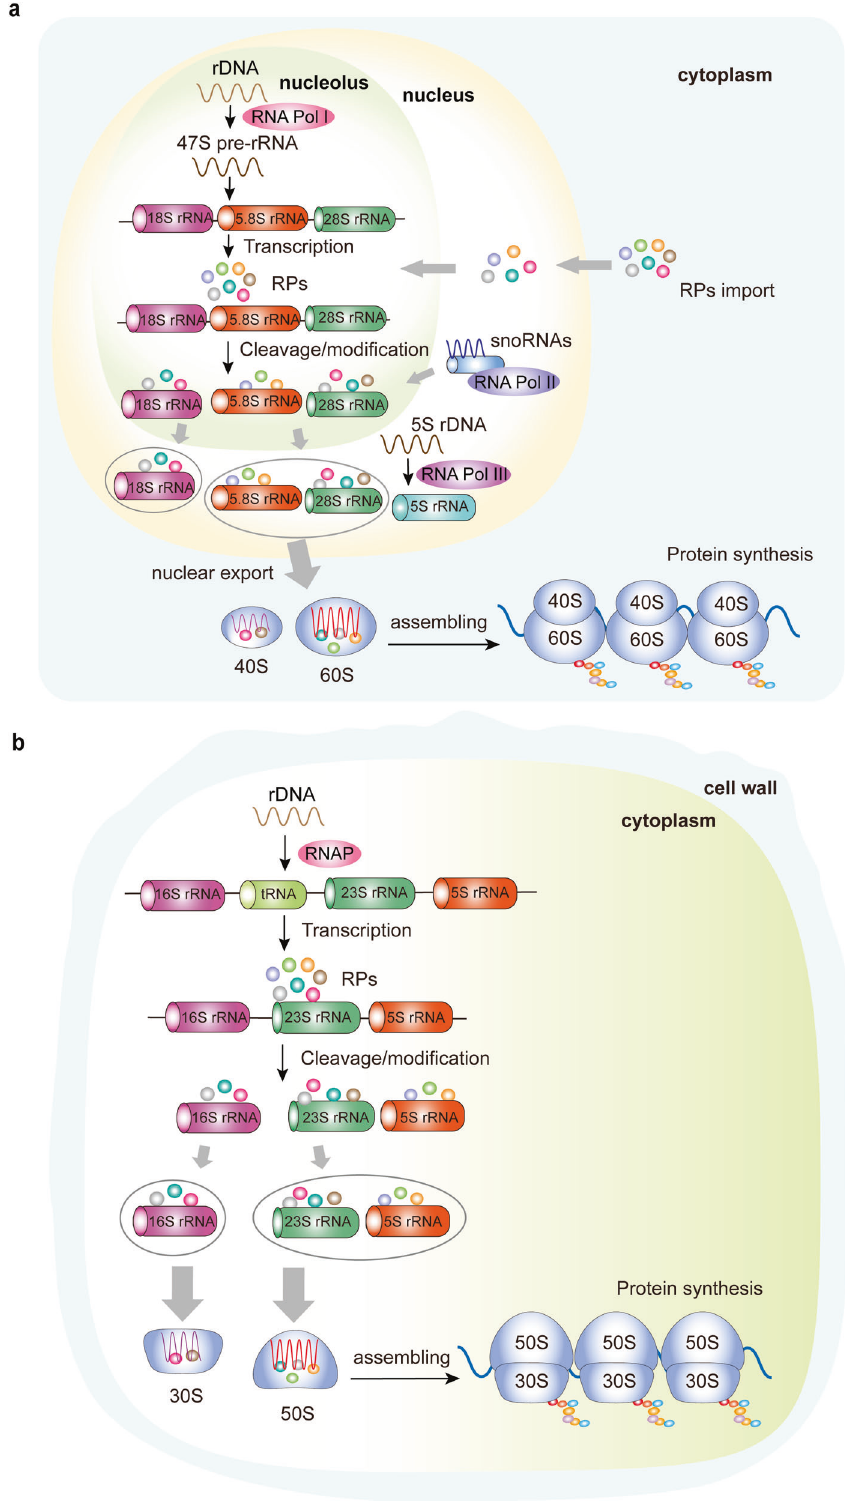
Fig. 1 Schematic of ribosome biogenesis. a Eukaryotic ribosome biogenesis is a highly orchestrated process involving RNA Pol I, Pol II, and Pol III, which are responsible for transcribing rDNA to rRNA, producing 47S pre-rRNA in the nucleolus. The 4 rRNAs then assemble together with RPs to form a small ribosomal subunit (40S) and a large ribosomal subunit (60S). After assembly, the ribosome complex is exported from the nucleolus to the cytoplasm to form mature ribosomes for protein synthesis. b Bacterial ribosome biogenesis starts with the transcription of the precursors of 23S, 16S, and 5S rRNAs, and some tRNAs in the cytoplasm. The rRNAs then assemble with RPs to form a 30S small subunit and a 50S large subunit. After assembly, the ribosome complex forms mature ribosomes for protein synthesis. RP ribosome protein, RNA pol Ι / II/III RNA polymerase Ι /II/III, RNAP RNA polymerase, rDNA ribosomal DNA, rRNA, ribosomal RNA, tRNA transfer RNA